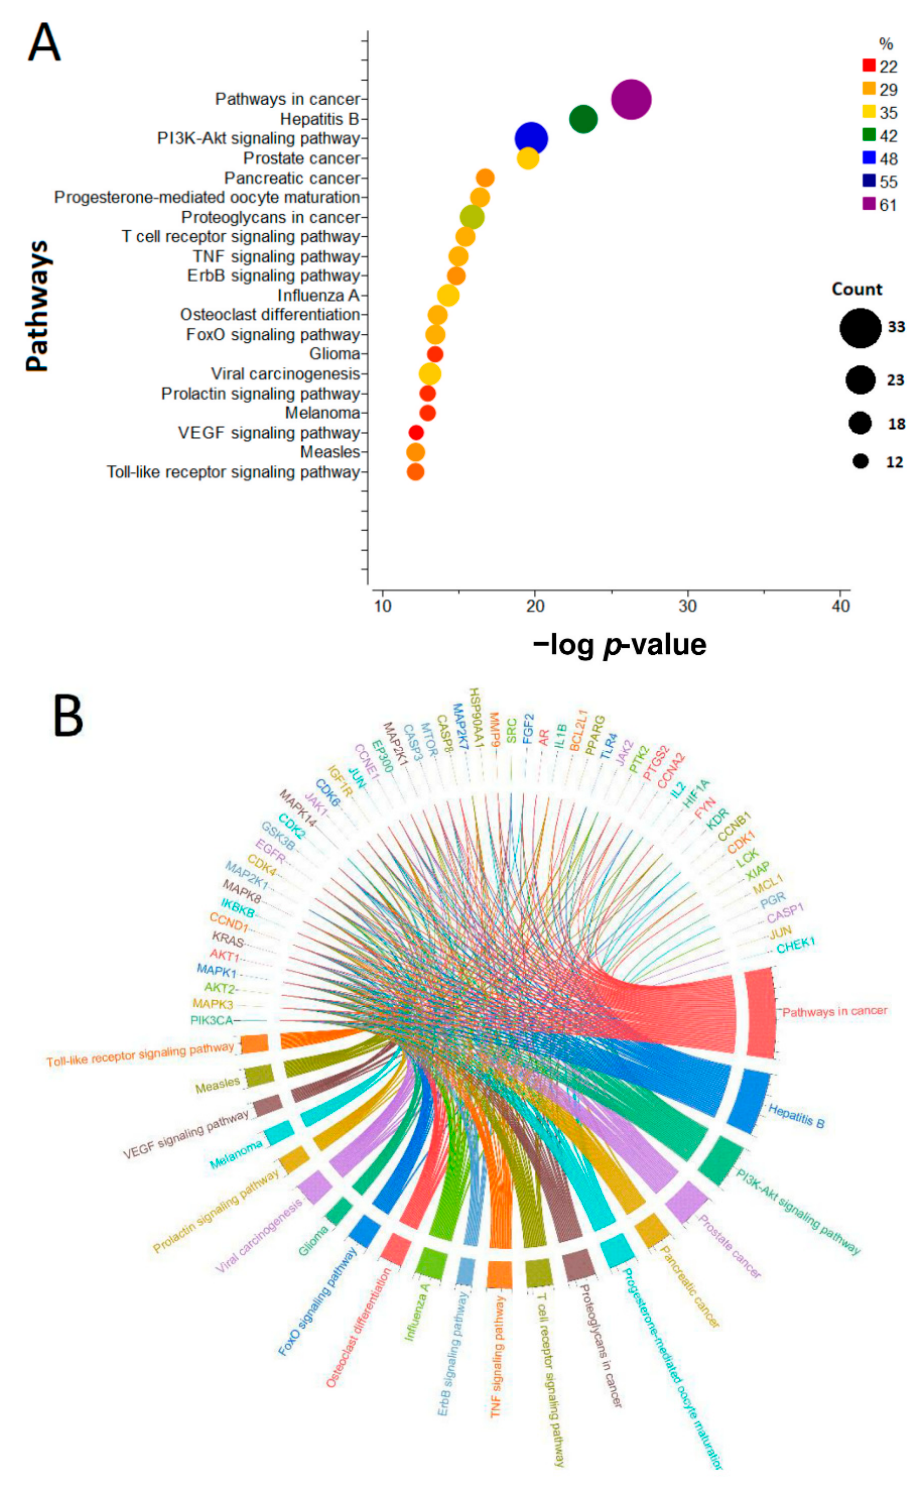
Figure 10. ( A ) Enrichment analysis on KEGG pathways of key targets from active compounds. ( B ) Core targets linked to top 20 KEGG pathways in Chord plot. Note: The size of the dots indicates the number of genes and the color of the dots represents the percentage.